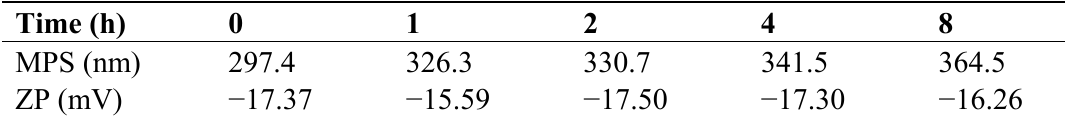
Table 2. Stability of